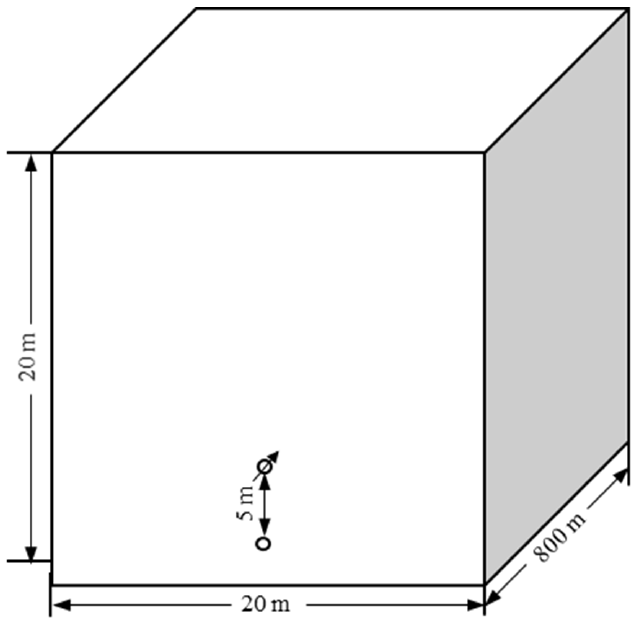
Figure 2. Schematic of the reservoir model used for the SAGD simulation. Table 1. Key reservoir model parameters.